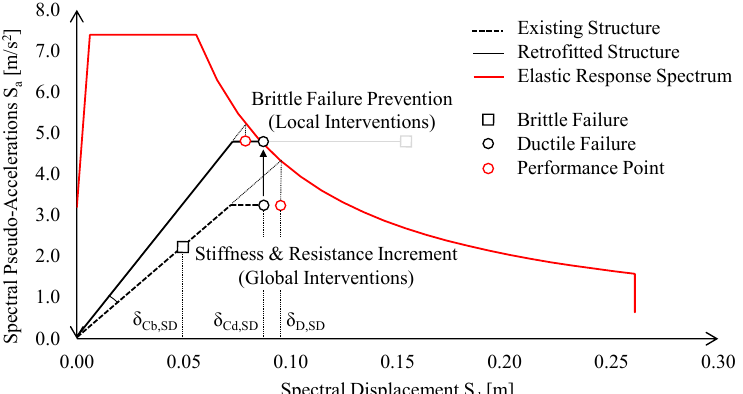
Figure 4. Graphical interpretation in ADRS domain for the design procedure of global retrofitting interventions.